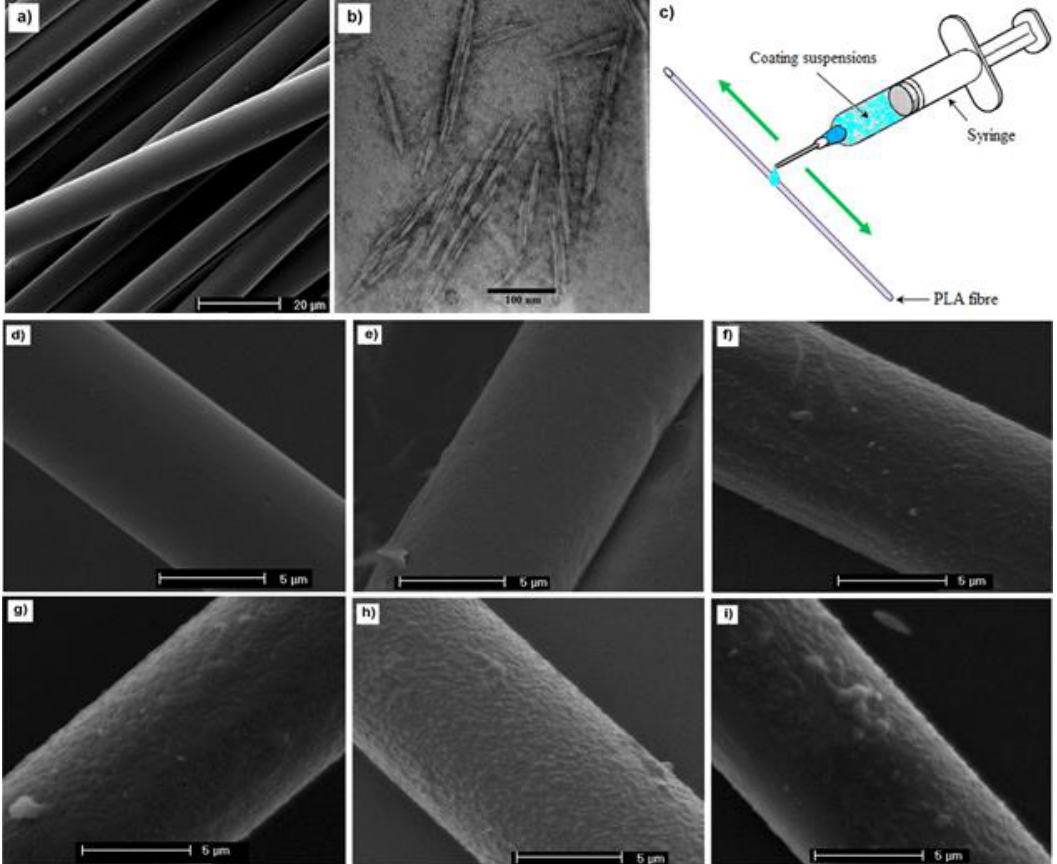
Figure 5. ( a ) Scanning electron microscopy (SEM) image of PLA fibers obtained at 400 m min − 1 ; ( b ) Transmission electron microscopy (TEM) of cellulose nanocrystals; ( c ) schematic of the coating procedure employed on the PLA fiber surface; and SEM images of: ( d ) noncoated; ( e ) PLA/PVAc; ( f ) PLA-CNCs-65; ( g ) PLA-CNCs-75; ( h ) PLA-CNCs-85; and ( i ) PLA-CNC-95 fibers. Reprinted from [84] Copyright ©2018 American Chemical